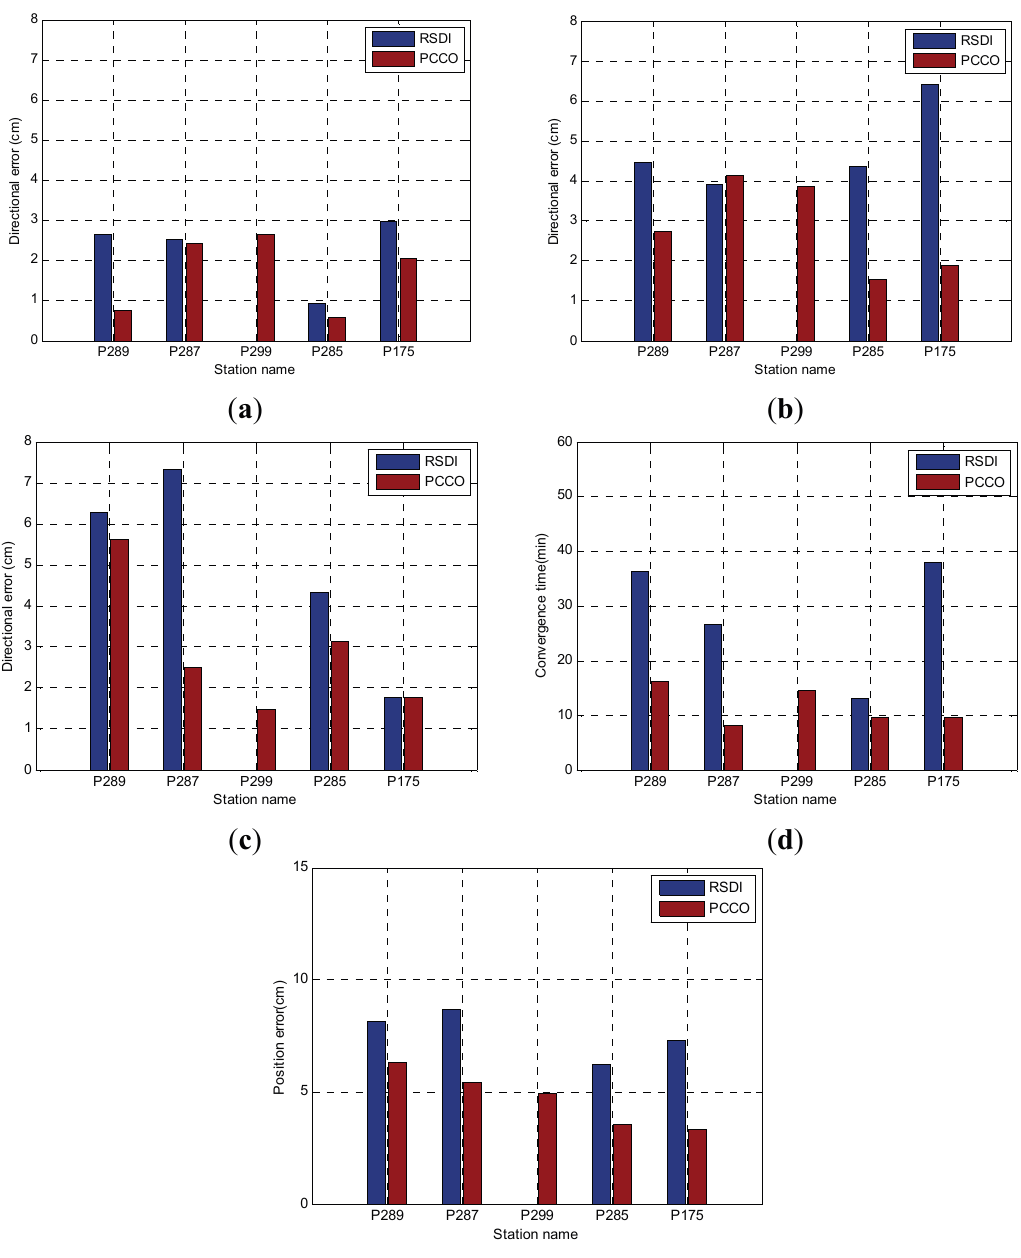
Figure 7. Results of the five stations within the network: ( a ) N; ( b ) E; ( c ) U; ( d ) convergence time; ( e ) position